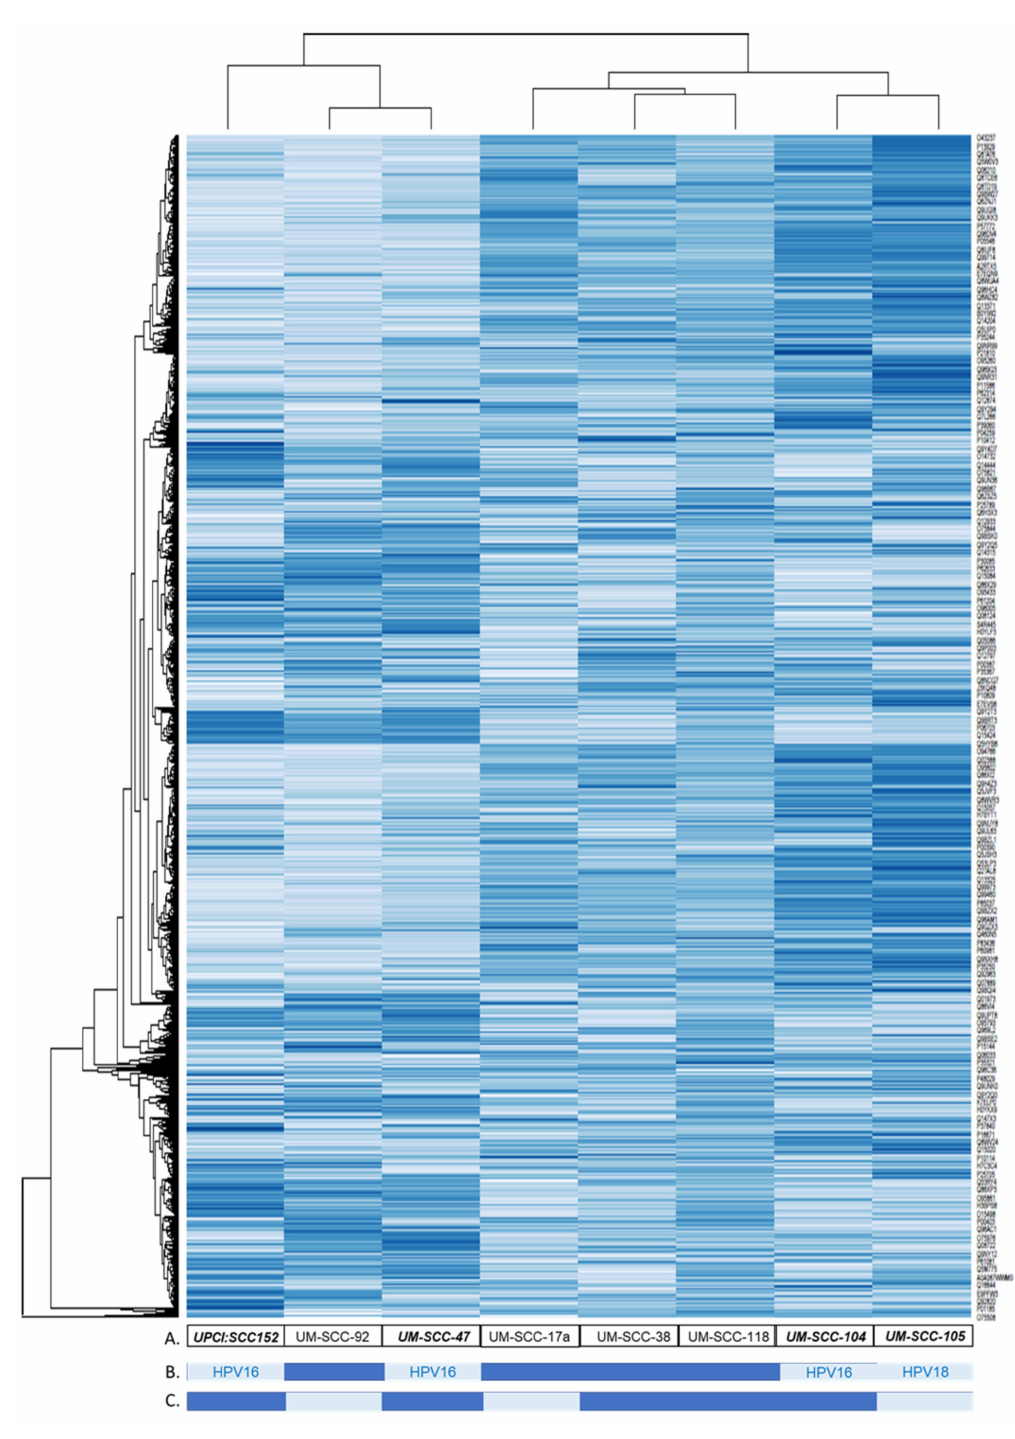
Figure 4. Cluster analysis of fold-change HNSCC EV protein abundance compared with NOKsi EV. protein. ( A ) UMSCC cell line EV identifier. ( B ) HPV status; light = HPV-positive, dark = HPV-negative. ( C ) Responsive/non-responsive origin tumor; light = responsive, dark = non-responsive. Bold italics: